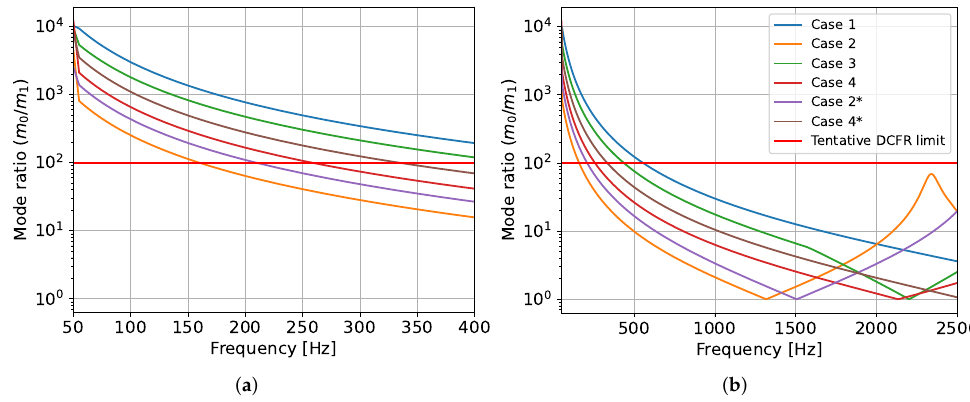
Figure 11. Dominant contribution factor ratio comparison sensitive to distance factor. ( a ) Frequencies ∈ [ 50;400 ] Hz. ( b ) Frequencies ∈ [ 50;2500 ]